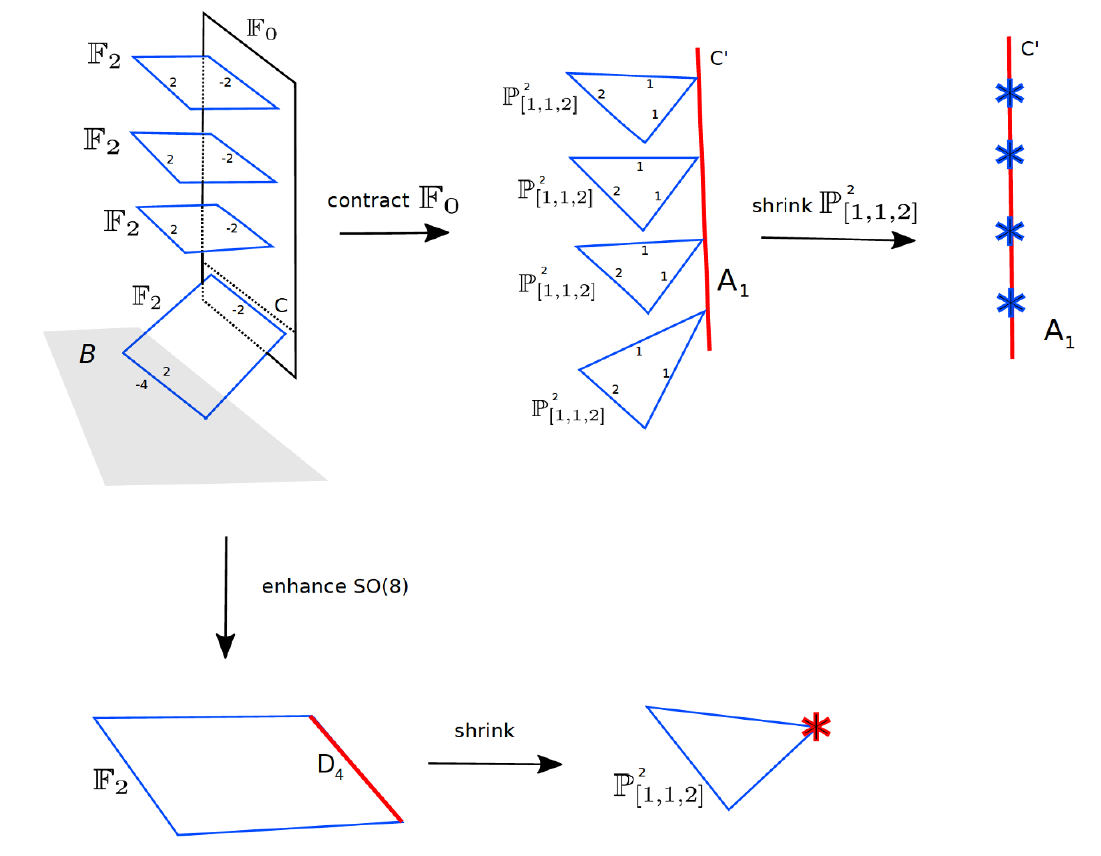
Figure 3 . Geometry of the (cid:0) 4 theory. upper left : reduction of the tensor branch over S 1 ; upper center : (cid:13)op phase transition; upper right : reduction of the 6D SCFT over S 1 lower left : gauge symmetry enhanced to SO(8); lower right : strong coupling limit of SO(8) theory. In the 5D limit, the A 1 locus and P 2 [1 ; 1 ; 2]